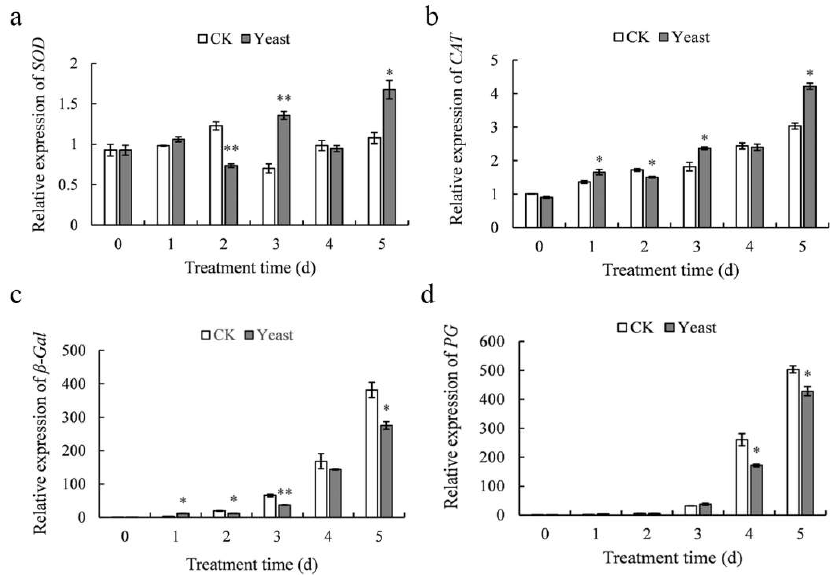
Figure 8. Effect of M. guilliermondii 37 on gene expression of SOD ( a ); CAT ( b ); β-Gal ( c ); and PG ( d ) in kiwifruit inoculated with B. dothidea for 5 days at 25 °C. The data are presented as mean ± SE. * denotes the significant level of differences between treatments according to Student’s t -test at p < 0.05, ** denotes the significant level of differences at p < 0.01.